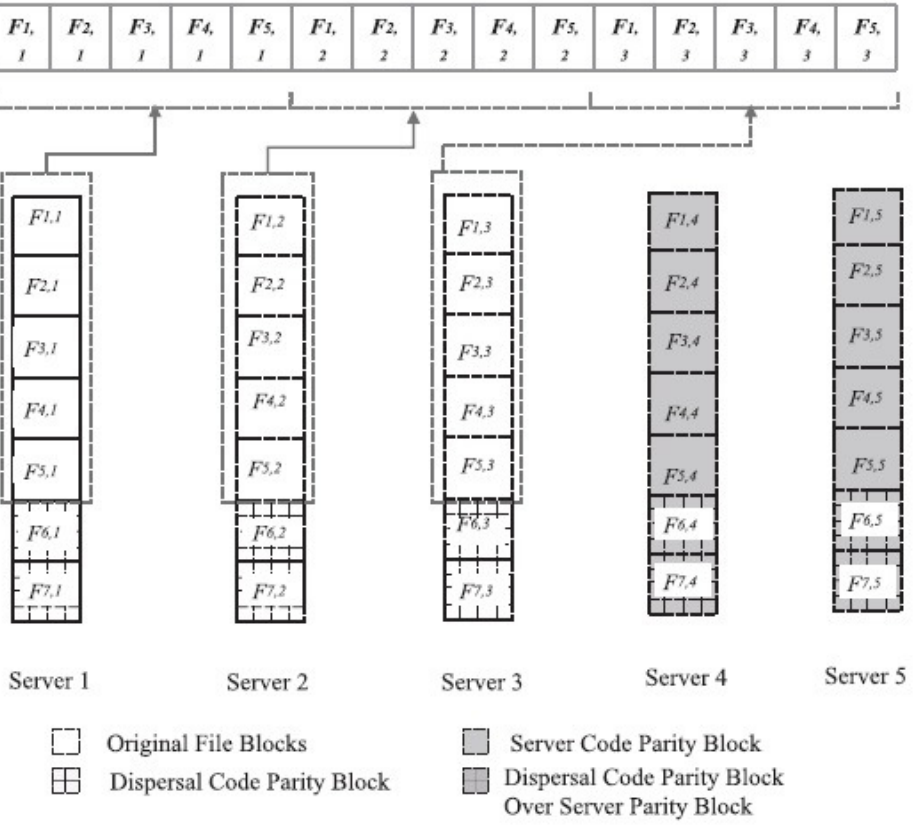
Fig. 6 Encoding of the Original File and Outsourcing to the Servers in HAIL